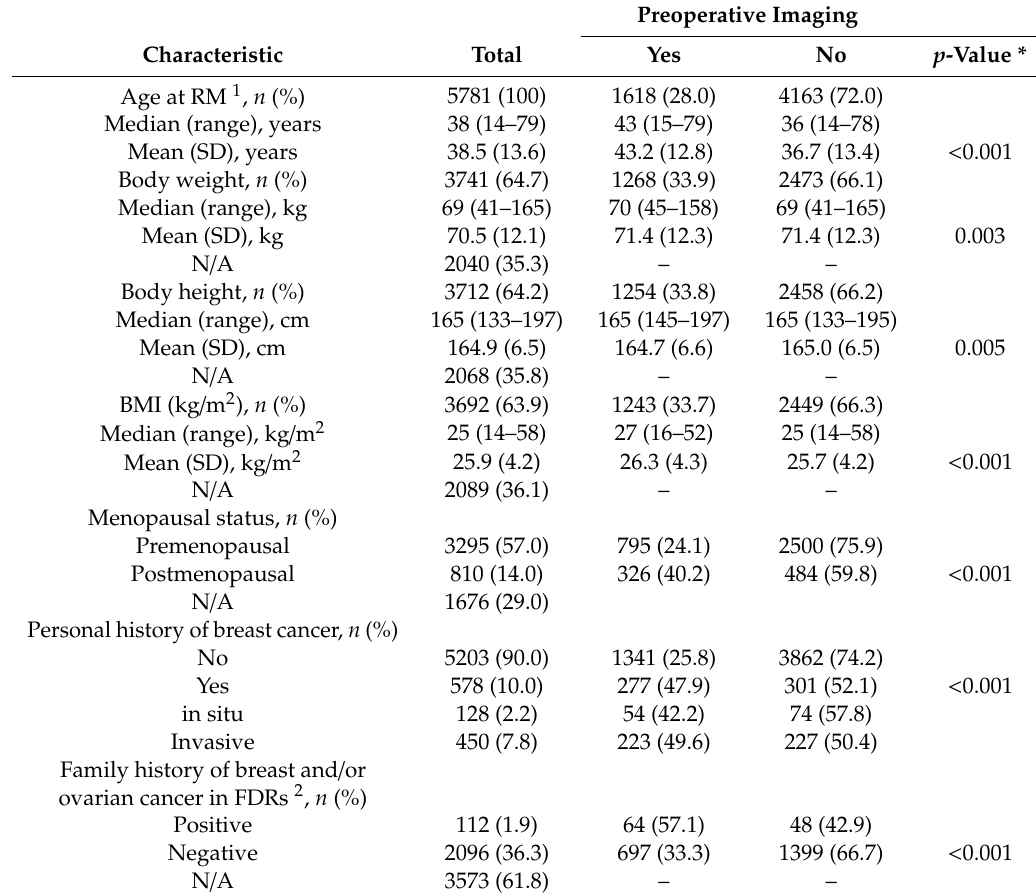
Table 1. Baseline characteristics of patients ( n = 5781).